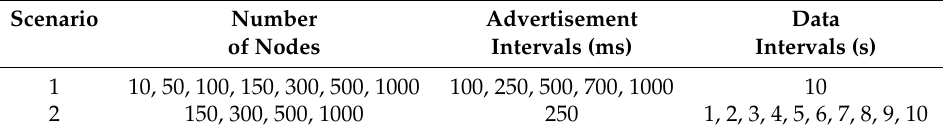
Table 4. Settings for the simulation